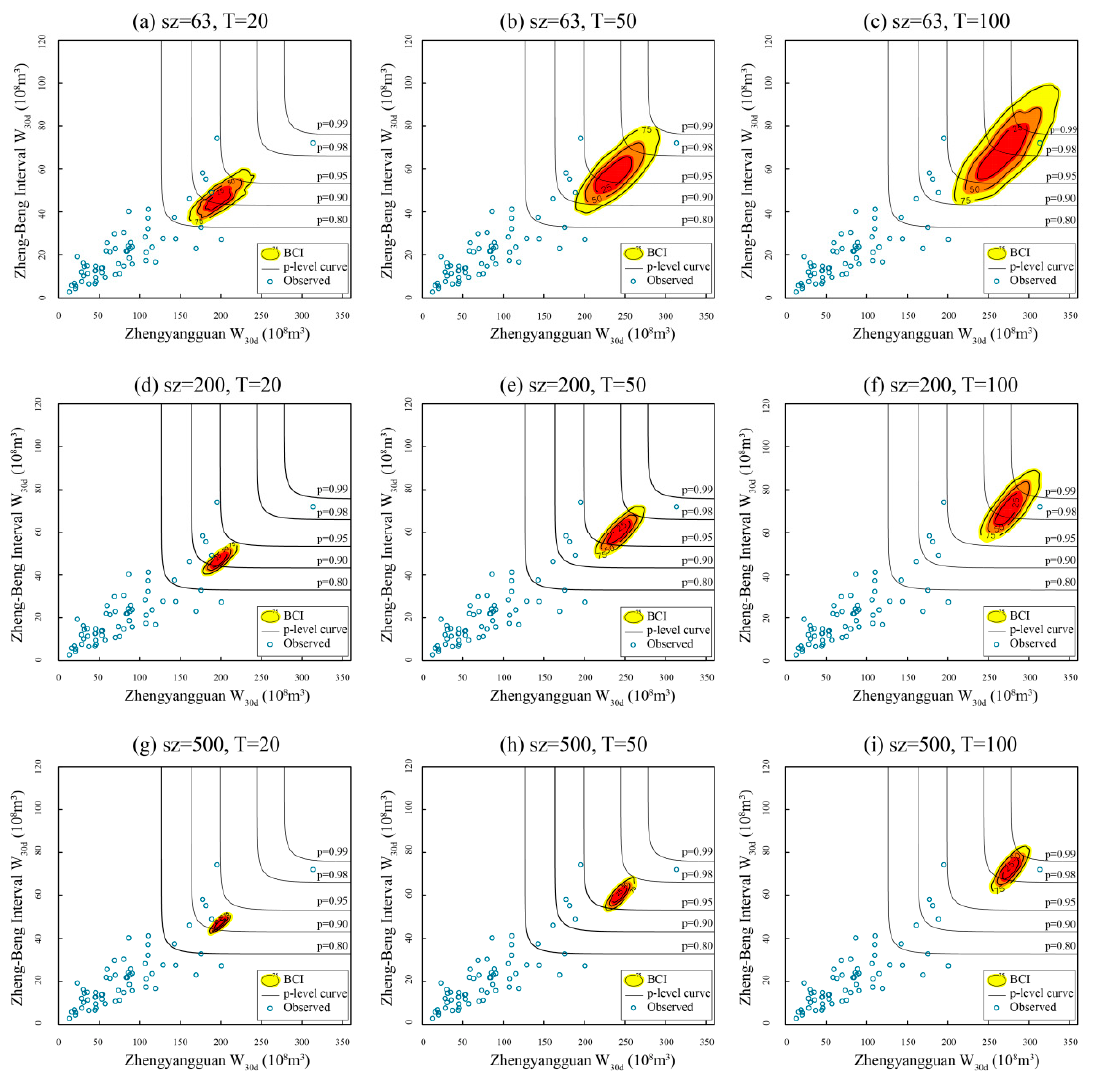
Figure 7. Comparison of CEC realizations under different schemes when the designed values occur in the Zhengyangguan section.